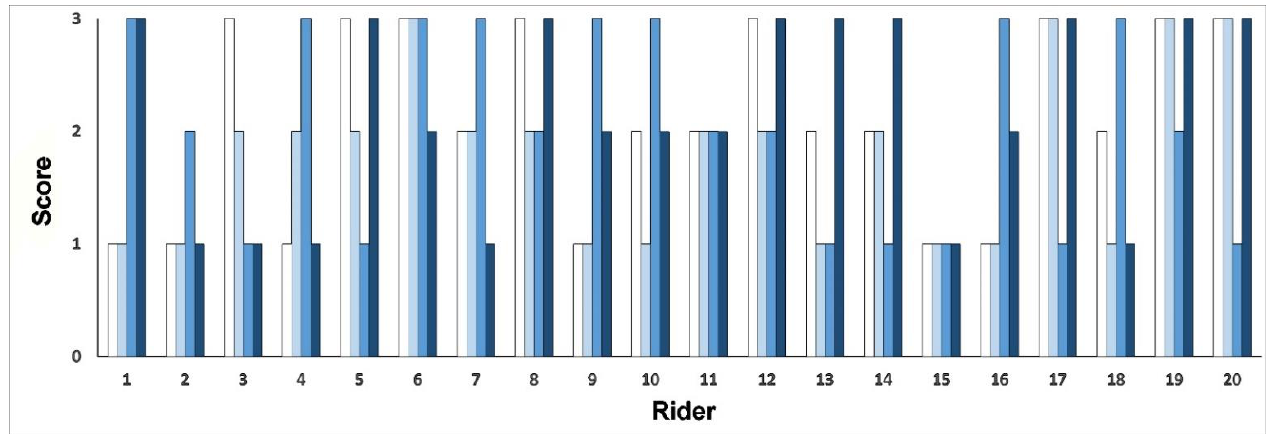
Figure 2. On the vertical axis, grade awarded for evaluation of rider performance (pelvic roll: white; pelvic circles: light blue; balance on ball: medium blue; quality and harmony of riding: dark blue) for 20 riders shown on the horizontal